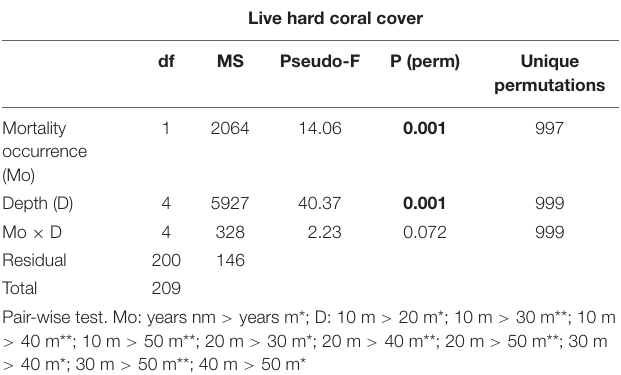
TABLE 6 | Results of two-way PERMANOVA on the percentage cover (in %) of live hard coral in the years without coral mortality (years nm) and years with coral mortality (years m), across a depth profile (10, 20, 30, 40, and 50 m) in the Maldives. Live hard coral